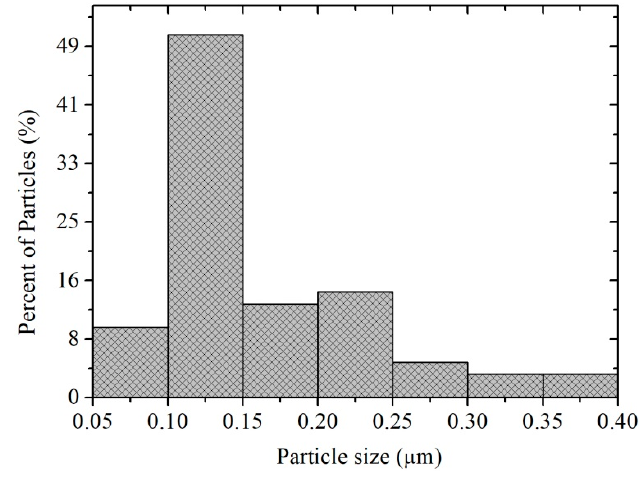
Figure 4. Size distribution of the particles that shape the MnSb 2 O 6 micro-rods obtained.